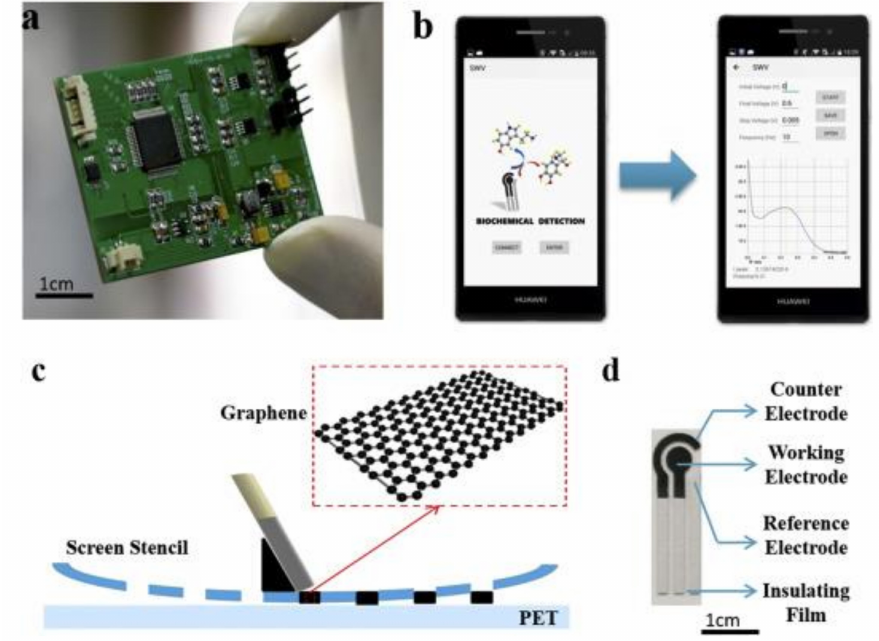
Figure 4. The images of ( a ) detector; ( b ) software interface; ( c ) scheme of screen-printing process, ( d ) image of SPE. Reprinted from [138] with permission of